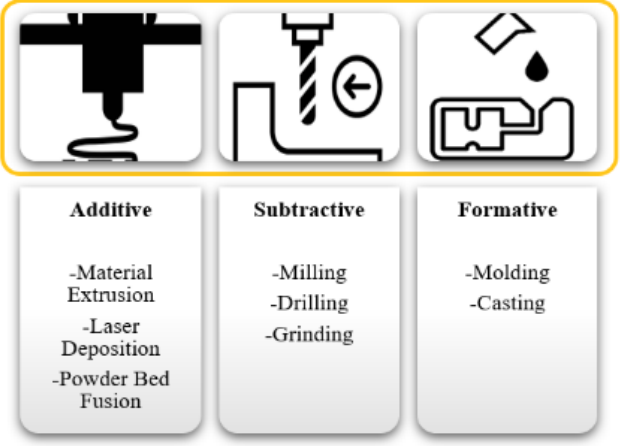
Figure 3. Different classes of conventional manufacturing.